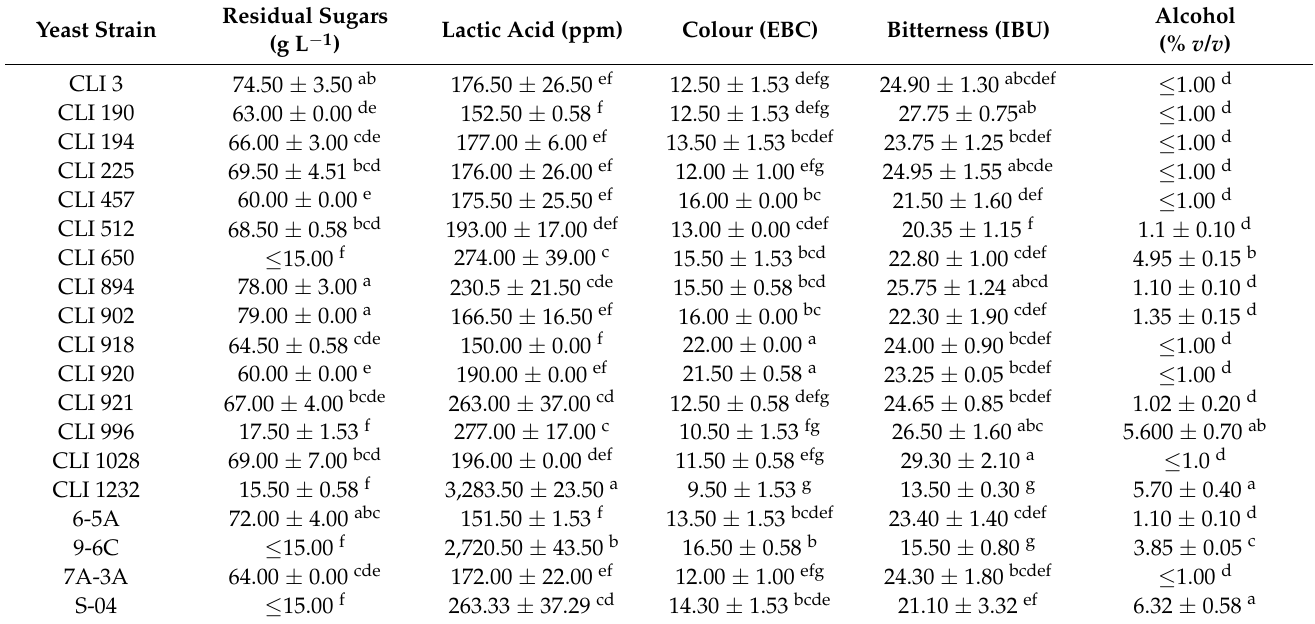
Table 2. Parameters analysed in 18 fermented beers in 100 mL with